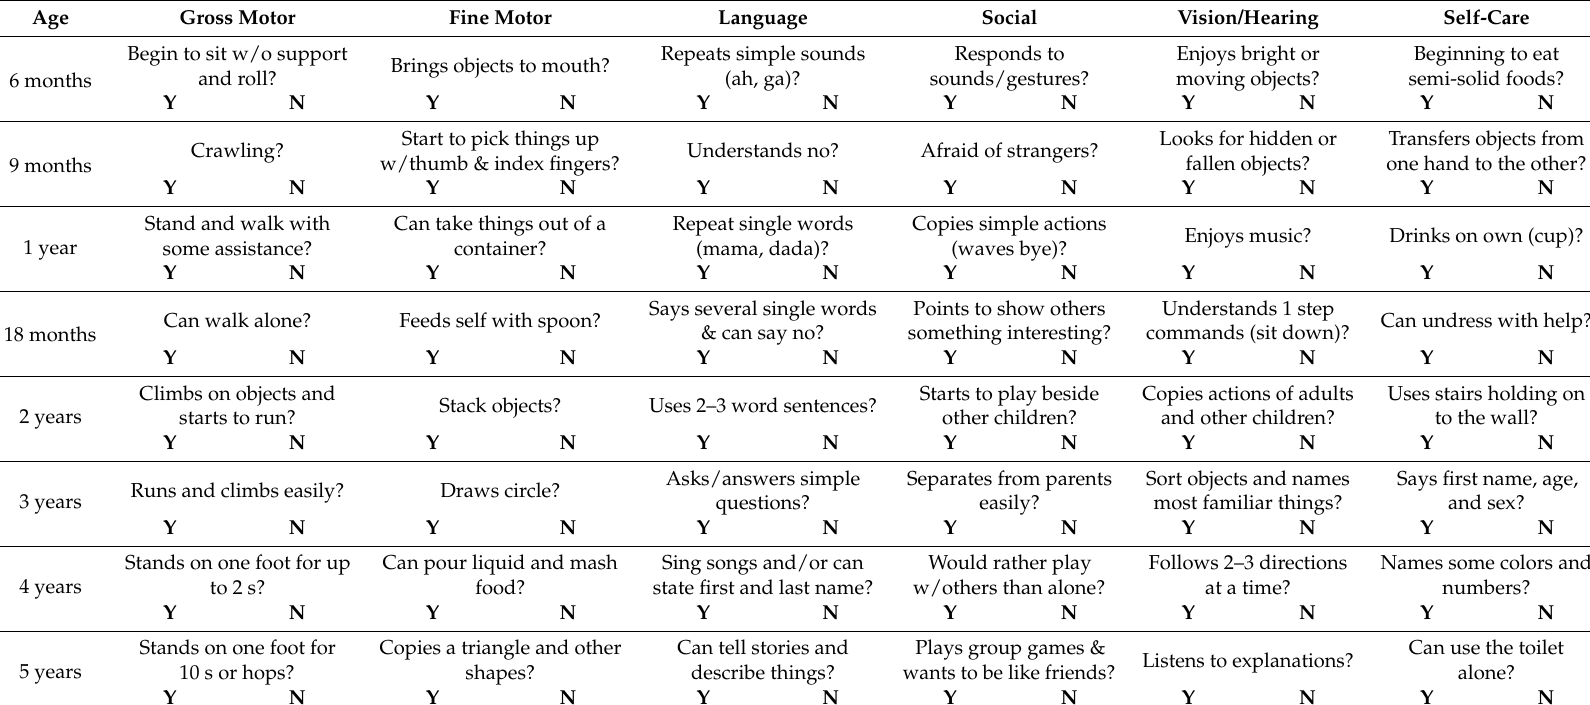
Table 1. Developmental screening